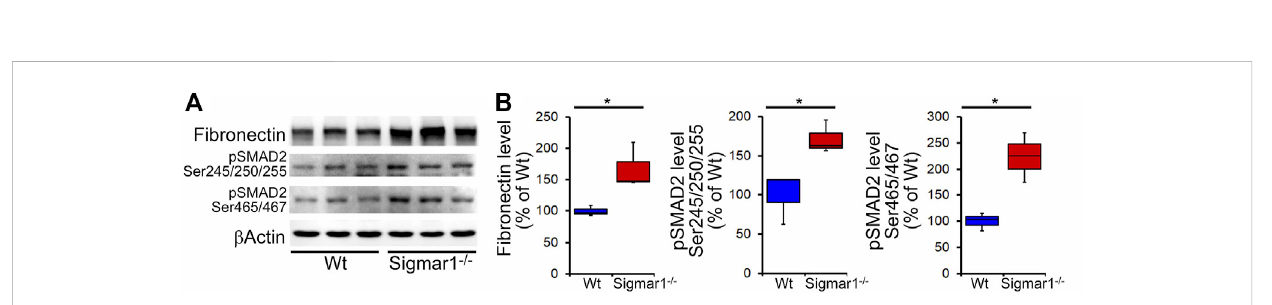
FIGURE 4 Increased fi brosis regulatory protein level in aged Sigmar1 − / − mouse lung. (A) Western blot images and (B) densitometry analysis showed increased fi bronectin, phospho-SMAD2 Ser245/250/255,and phospho-SMAD2 Ser465/467 proteinlevels inaged Sigmar1 − / − mouse lungscomparedto agematch littermate Wt mouse lungs (n = 3 per group). The Kruskal – Wallis test determined p values, and p < 0.05 was considered statistically signi fi